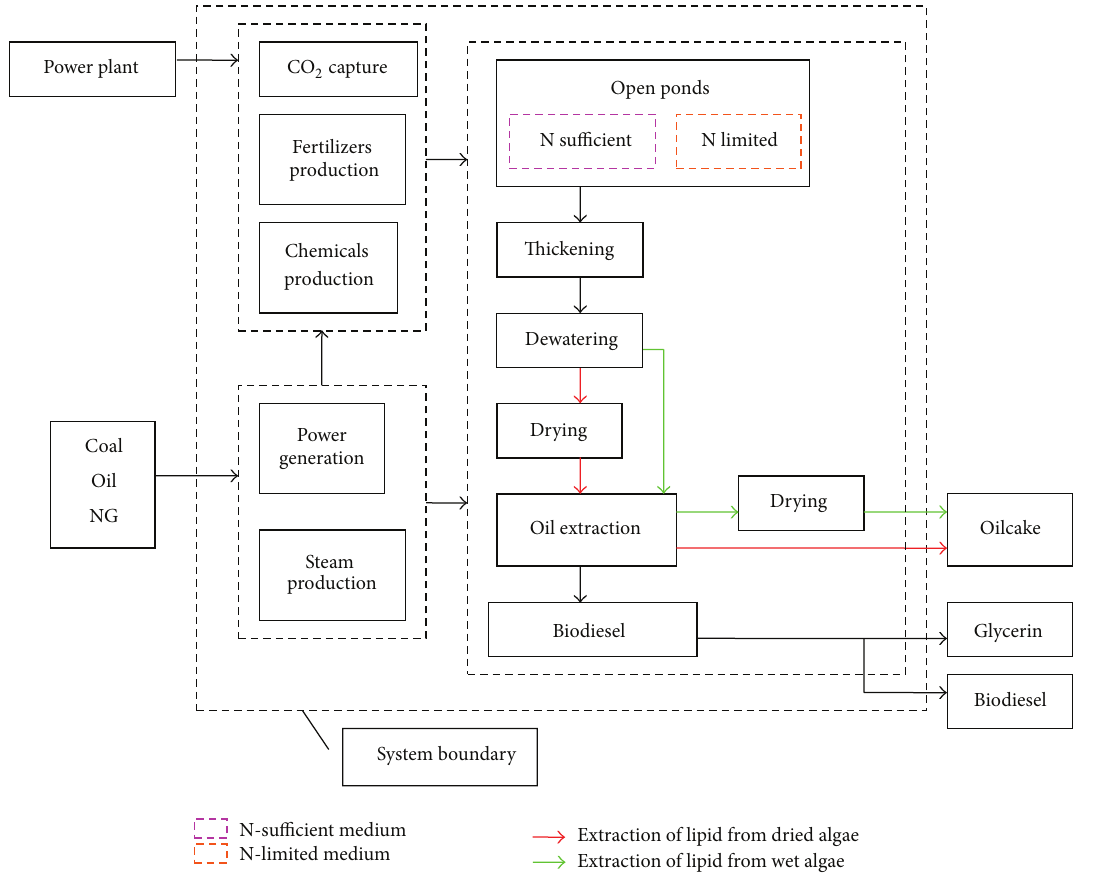
Figure 1: Life cycle system of biodiesel production from